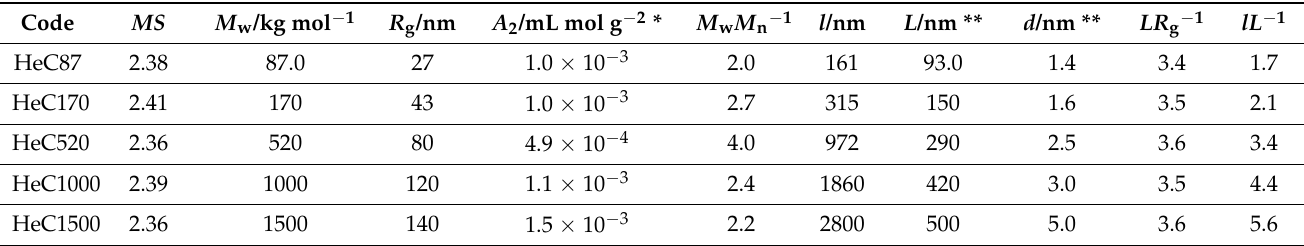
Table 1. Characteristics of the examined HeC samples: molar substitution number, MS (by hydrox- yethyl groups), weight average molar mass, M w , radius of gyration, R g , second virial coefficient, A 2 , polydispersity index, M w M n − 1 , average molecular contour length, l , particle length, L , particle diameter, d , and ratios, LR g − 1 and lL − 1